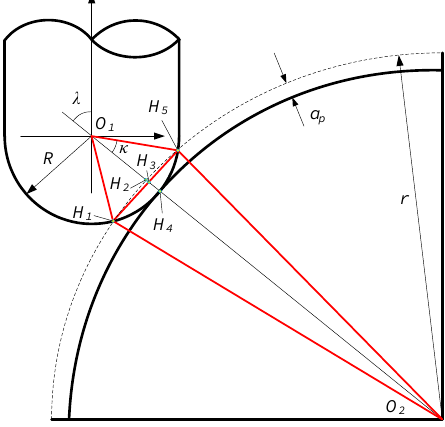
Figure 5. Geometric relationship of the contact area between the tool and the workpiece.